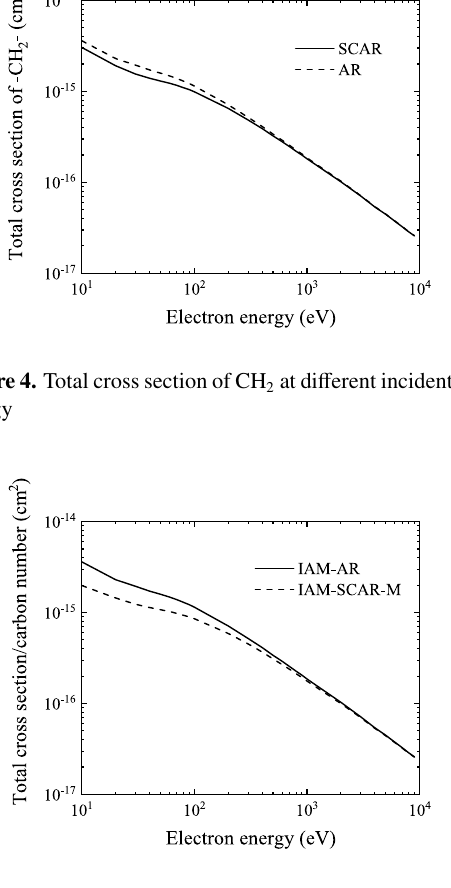
Figure 5. Total cross section of polyethylene at di ff erent incident electron